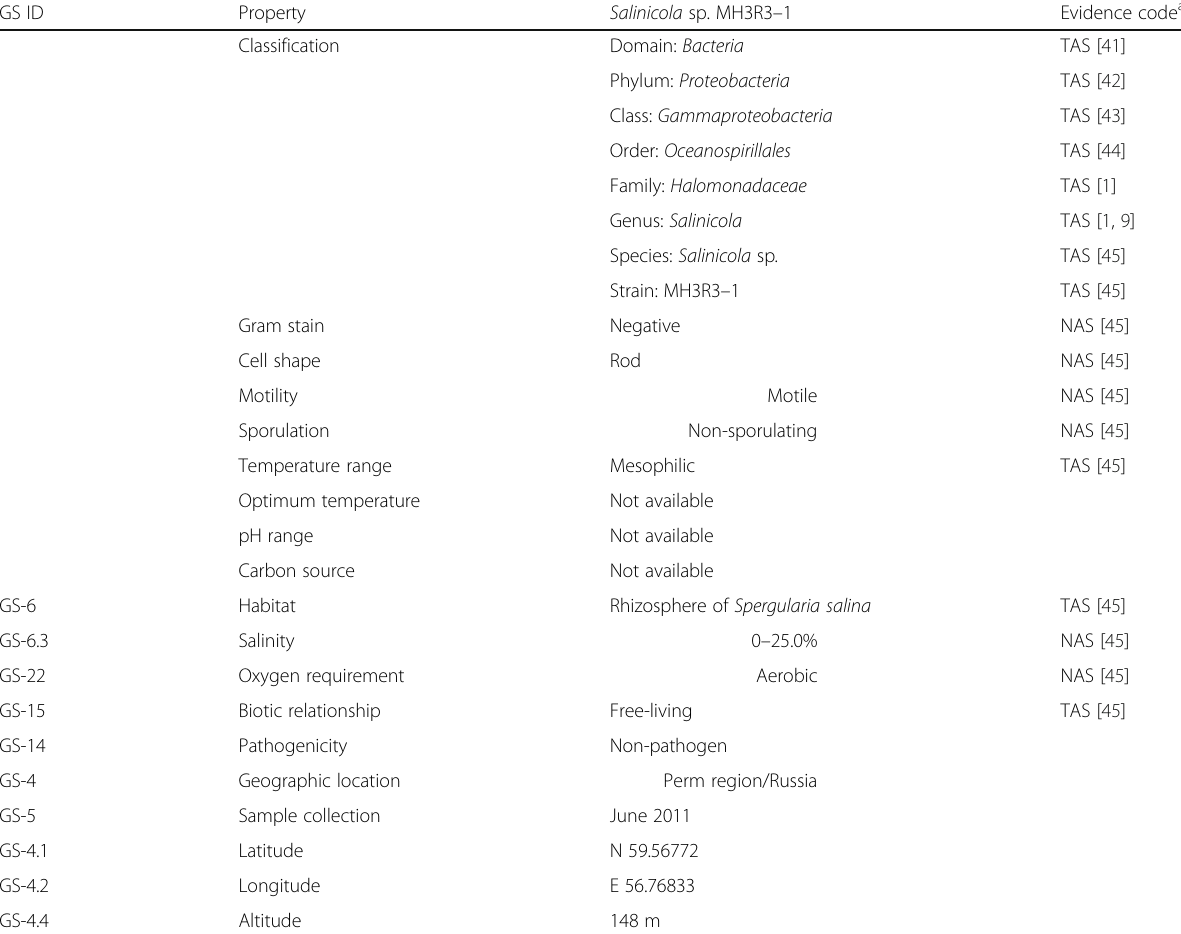
Table 2 Classification and general features of Salinicola sp. MH3R3 – 1 MIGS